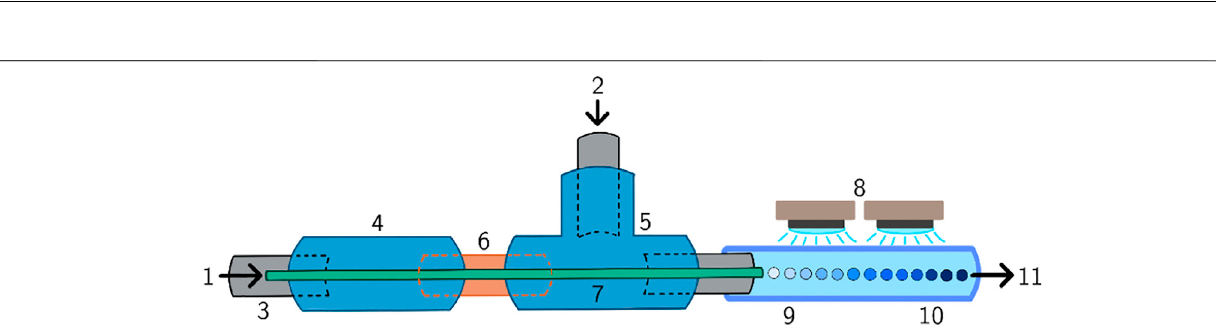
Frontiers in Bioengineering and Biotechnology |